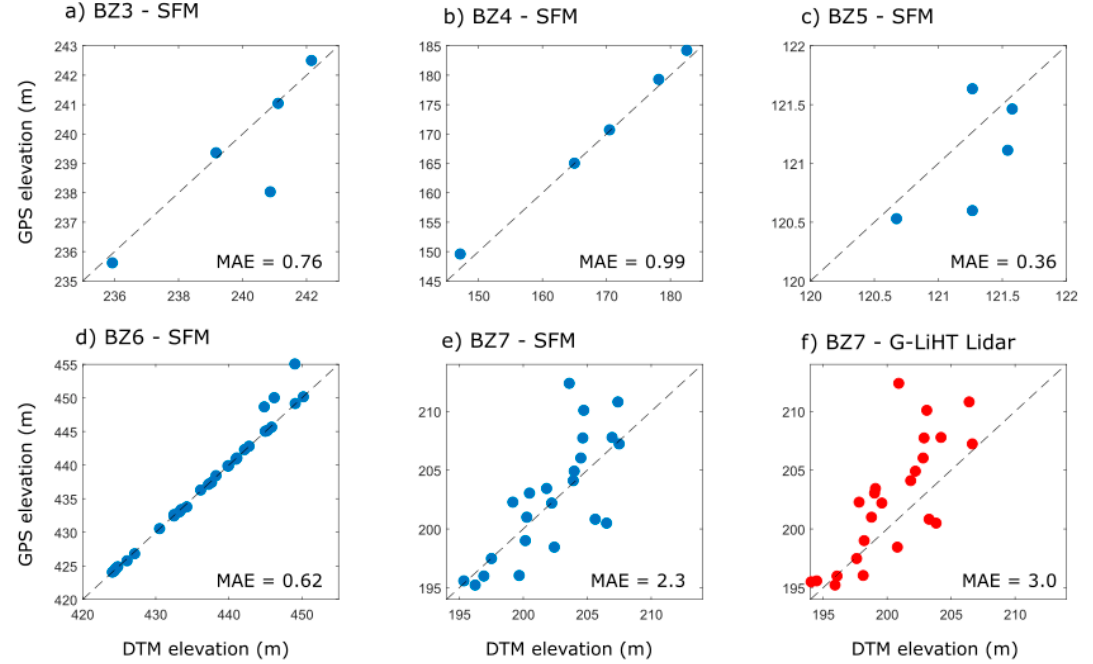
Figure 2. Digital terrain model (DTM) compared to differential GPS: ( a ) through ( e ) are SfM-derived and ( f ) is the same plot as ( e ) but showing the DTM from Goddard Lidar Hyperspectral Thermal platform (G-LiHT) data. Red color is to differentiate G-LiHT data from SfM data (in blue). Error is reported as mean absolute error (MAE).